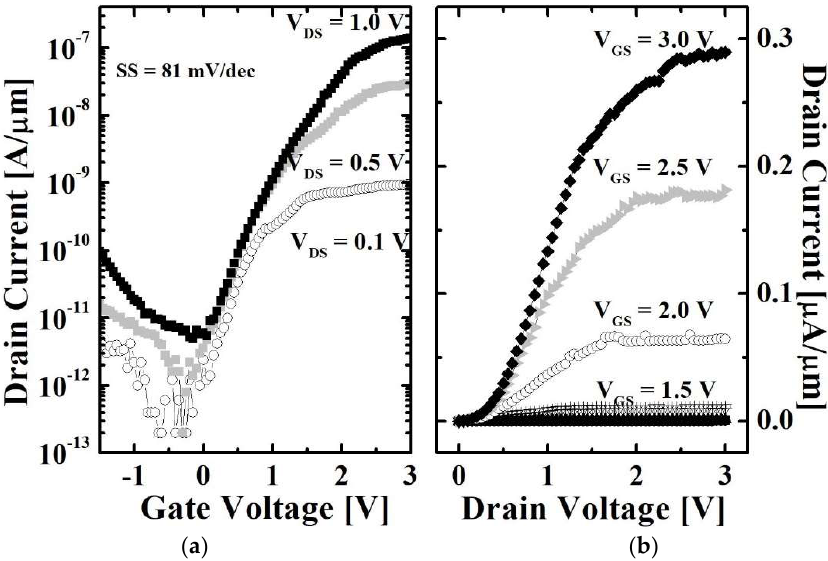
Figure 7. ( a ) Transfer and ( b ) output characteristics of proposed TFET.